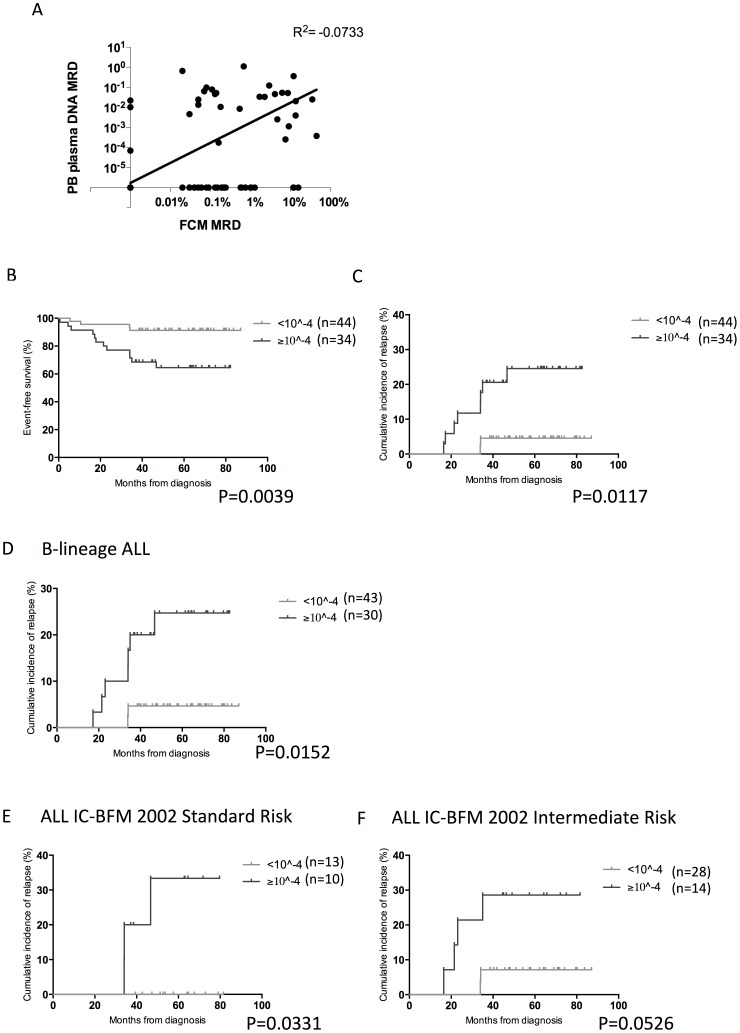
Prognostic significance of MRD as detected by PB plasma DNA PCR at day 15.(A) Correlation of PB plasma DNA MRD with FCM MRD at day 15. Spearman r test was used for statistical analysis. (B–C) Comparison of PB plasma DNA MRD level (cutoff: 10−4) at day 15 with (B) event-free survival and (C) occurrence of relapse. (D–F) Incidence of relapse for patients stratified according to PB plasma MRD cutoff at 10−4 with (D) B-lineage ALL, in ALL IC-BFM 2002 standard risk (E) or intermediate risk (F).